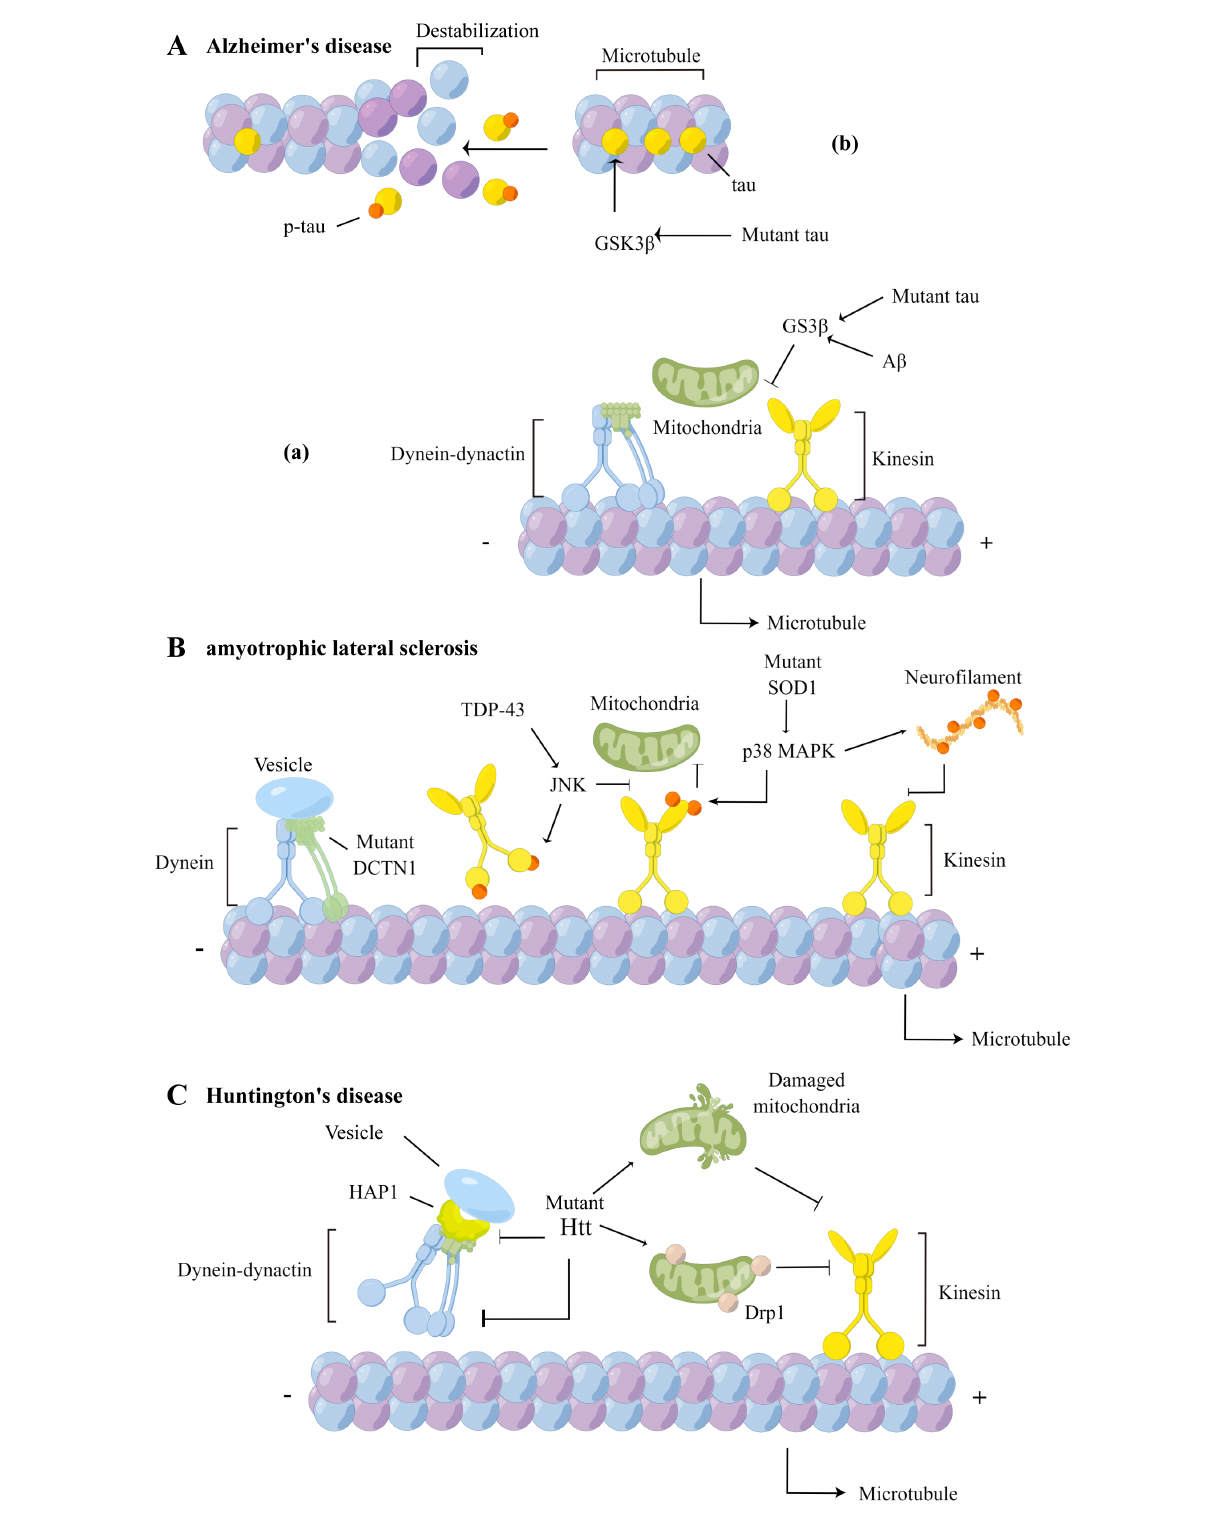
FIGURE 2 Axonal transport defects in AD, ALS and HD. (A) In AD, over-activation of GSK3 β increases phosphorylation of tau (b), reducing affinity of tau to microtubules and causing structural changes in microtubules, and affects the binding of cargoes to motor proteins (a). (B) In ALS, the DCTN1 mutation affects the retrograde transport of cargoes; TDP-43 inhibits the binding of kinesin to microtubules by affecting JNK activity and phosphorylating the kinesin motor domains ; mutant SOD1 activates p38 MAPK, leading to hyperphosphorylation of the kinesin light chain and inhibition of binding to cargo proteins; activated p38 MAPK also phosphorylate NF and inhibit the binding of NF to kinesin; (C) In HD, mutant Htt can not only interacts with dynein and HAP1, affecting the retrograde transport function of dynein, but also interact with mitochondria, leading to mitochondrial structural damage and axonal transport impairment. The HAP1-mediated axonal transport is disrupted by mutant Htt as